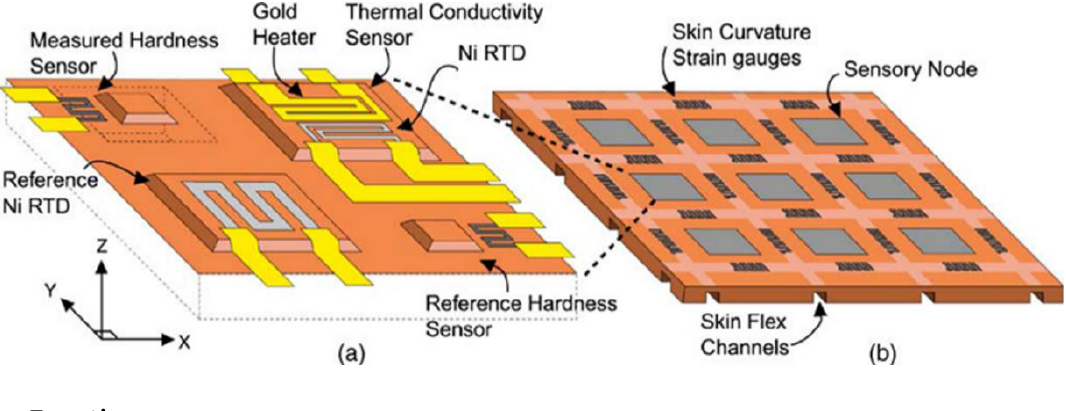
Figure 4. Multimodal sensor performing measurements of hardness, temperature, thermal conductivity and curvature of object